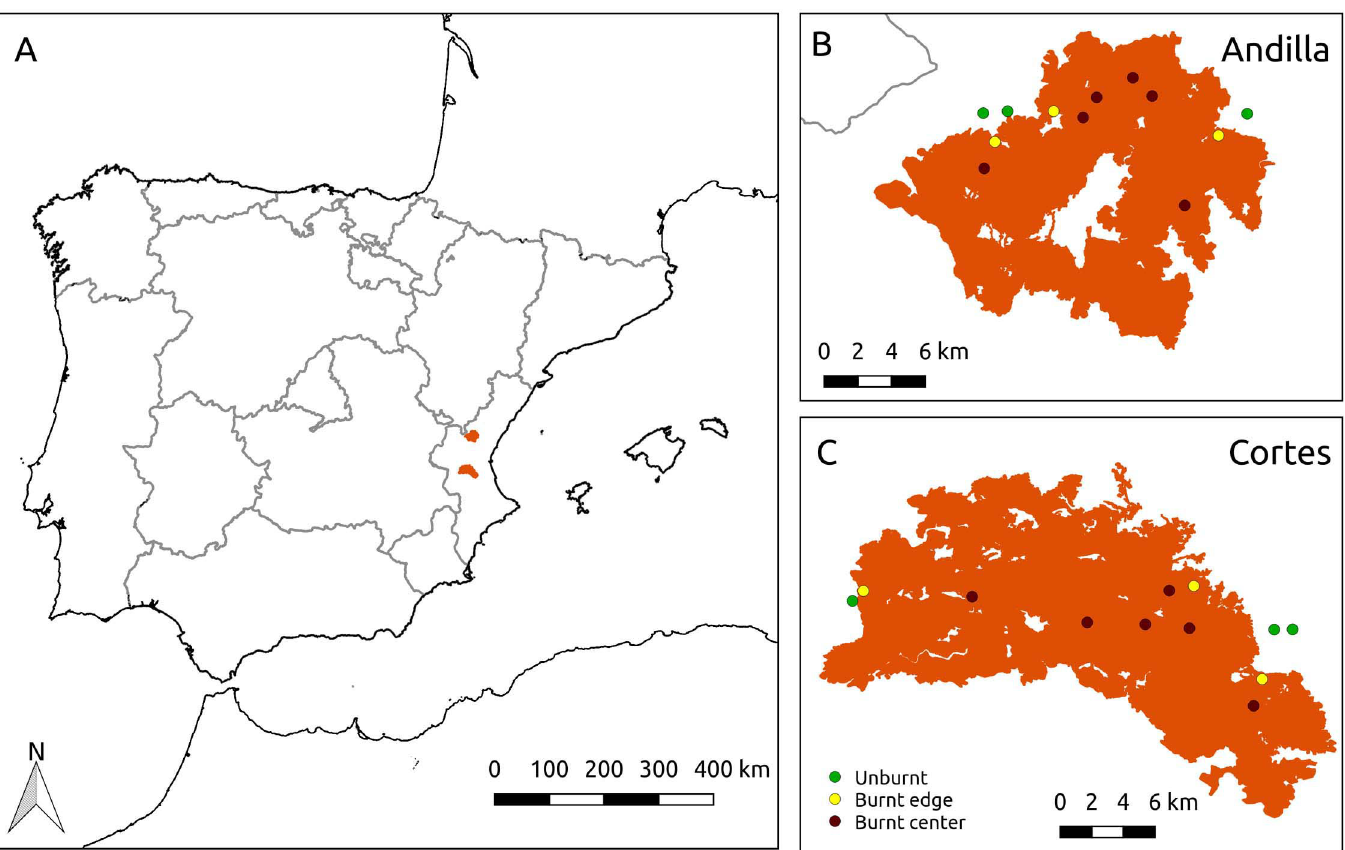
Fig 1. Location of the two study areas at the eastern of the Iberian Peninsula. (A) Location of the two burnt areas (in orange) in the Valencia region, eastern Iberian Peninsula (Andilla is more to the north than Cortes). (B) Andilla burnt area (ca. 21,000 ha). (C) Cortes burnt area (ca. 30,000 ha; Table 1). In A and B, symbols are the location of the sampled plots (green: unburnt; yellow: burnt edge; dark: burnt center). Unburned patches are basically towns, farms and farmland without natural vegetation.